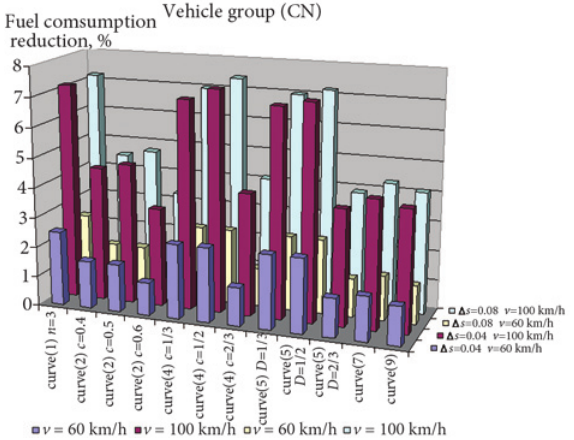
Fig. 7. Fuel consumption reduction in variant B, %, in vehicle group (SB)